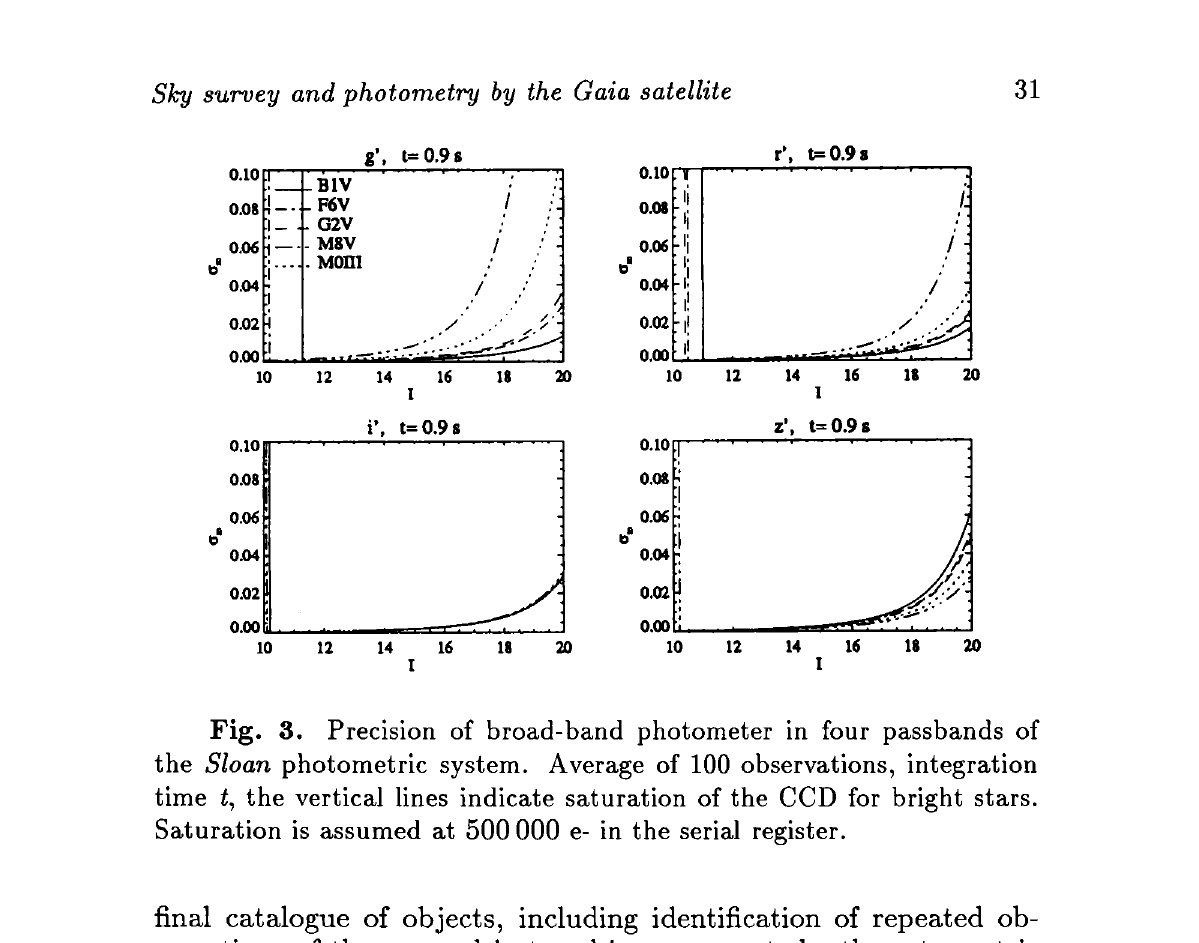
Fig. 3. Precision of broad-band photometer in four passbands of the Sloan photometric system. Average of 100 observations, integration time t, the vertical lines indicate saturation of the CCD for bright stars. Saturation is assumed at 500 000 e- in the serial